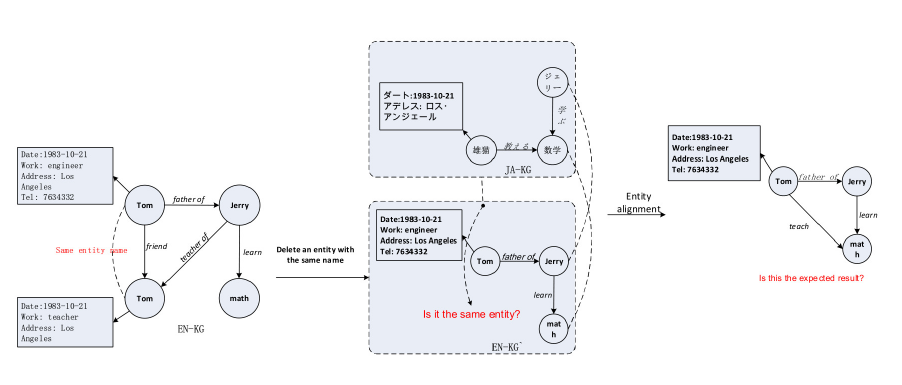
Figure 6. Entity alignment of the knowledge graphs containing the same head and tail entity names. JA-KG and EN-KG represent the Japanese knowledge graph and English knowledge graph,